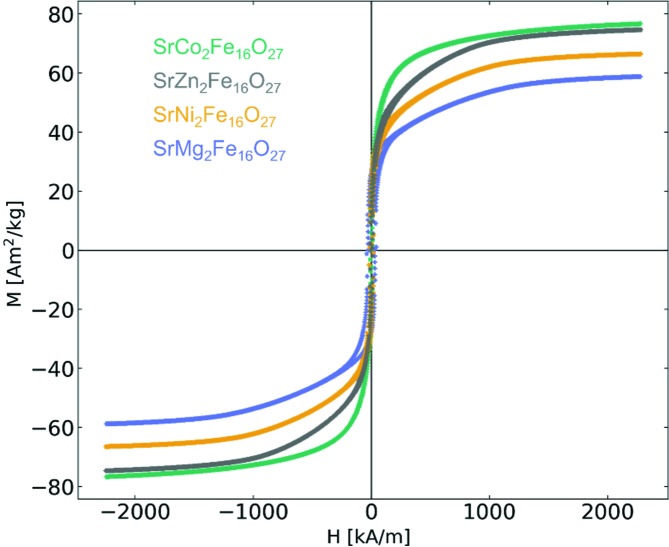
Magnetic hysteresis for the four SrMe
2Fe16O27 (Me = Mg, Co, Ni, Zn) samples. The samples were measured using an applied field of ±3 T with a PPMS-VSM.